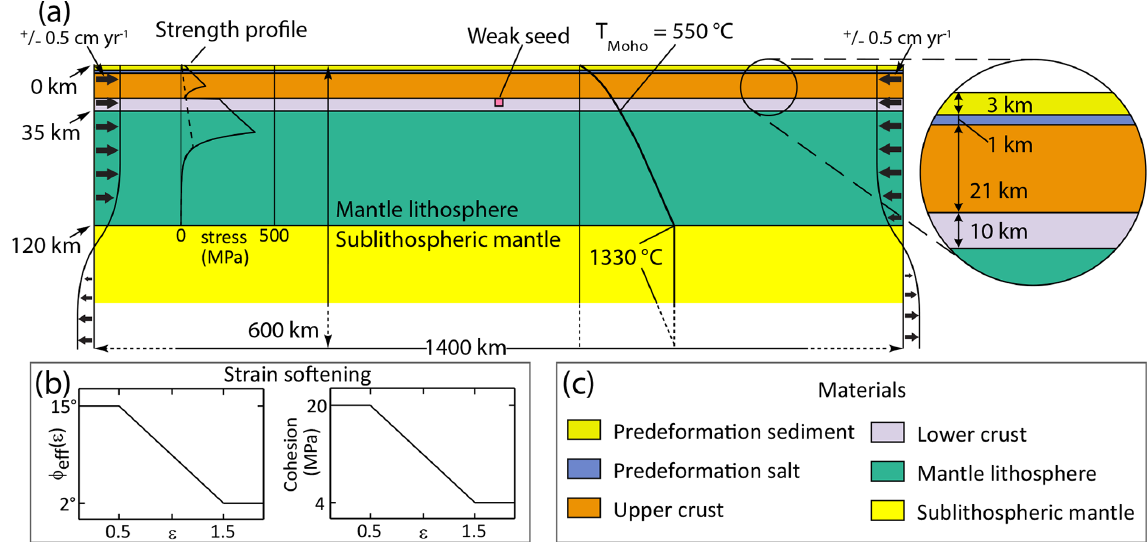
Figure 2. (a) Model geometry showing layer thicknesses (including a close-up of the crust), the position and size of the weak seed (pink square), the lateral velocity boundary conditions (black arrows along the sides of the box; note the ± sign), and the initial strength and temperature profiles of the models. The material properties corresponding to each layer (including the syn-tectonic sediments) are presented in Table 1. (b) Frictional plastic strain softening is achieved through a linear decrease in φ eff from 15 to 2 ◦ with a simultaneous decrease in C from 20 to 4MPa. (c) Legend for materials shown in (a)